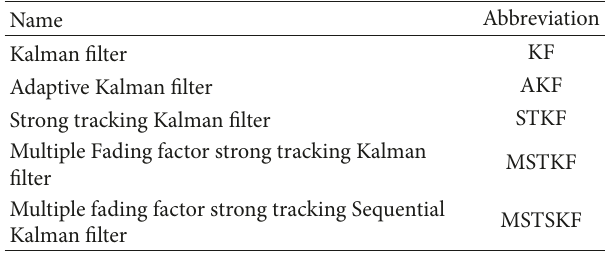
Table 1: Summarizing table about the different versions of